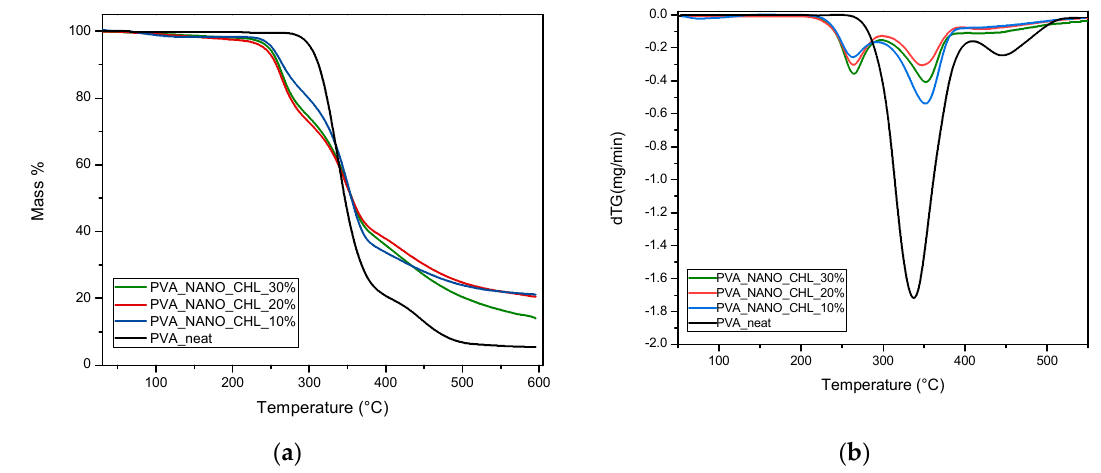
Figure 8. ( a ) Thermogravimetric analysis of PVA and PVA/CNF/CHL composites. ( b ) dTG analysis of PVA and PVA/CNF/CHL composites.